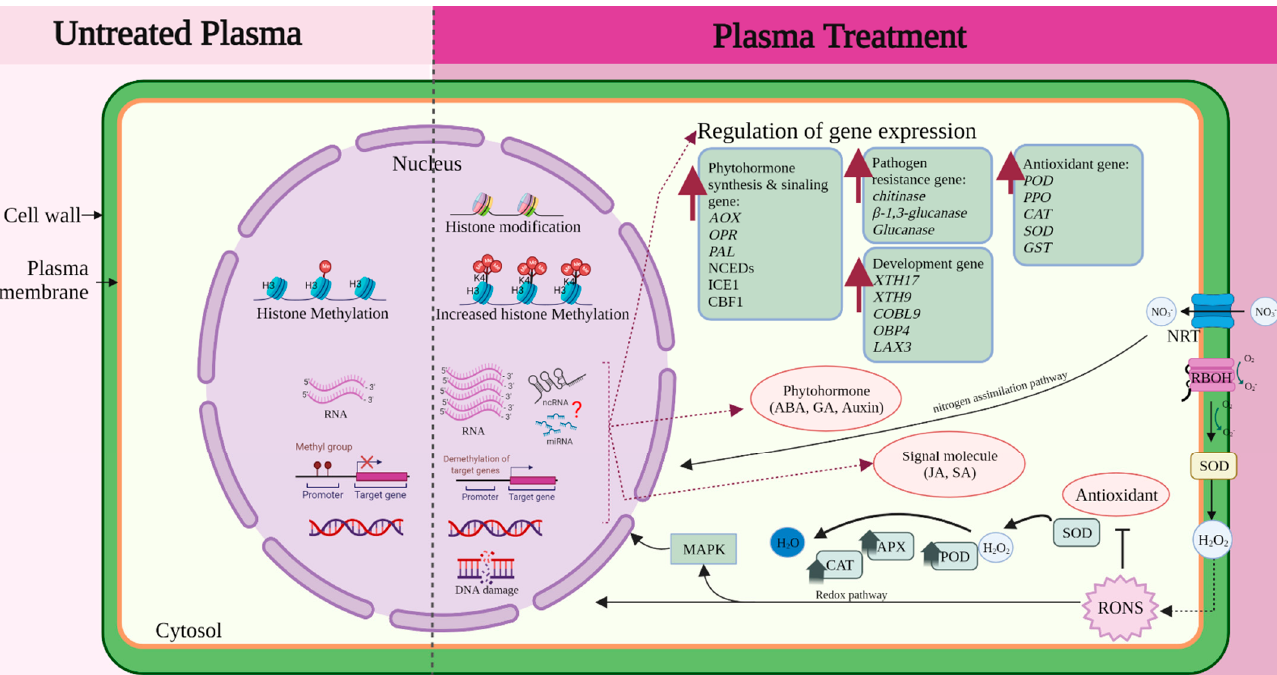
Figure 3. Simplified overview of the molecular mechanisms underlying the effects of plasma treatment. Molecular mechanism underlying the effects of plasma treatment involve complex mechanisms in plant cells including transport activity, signaling molecules, enzyme activity, hormone regulations, gene expression, and DNA and histone modification. Various genes are regulated by redox and nitrogen assimilation pathways.